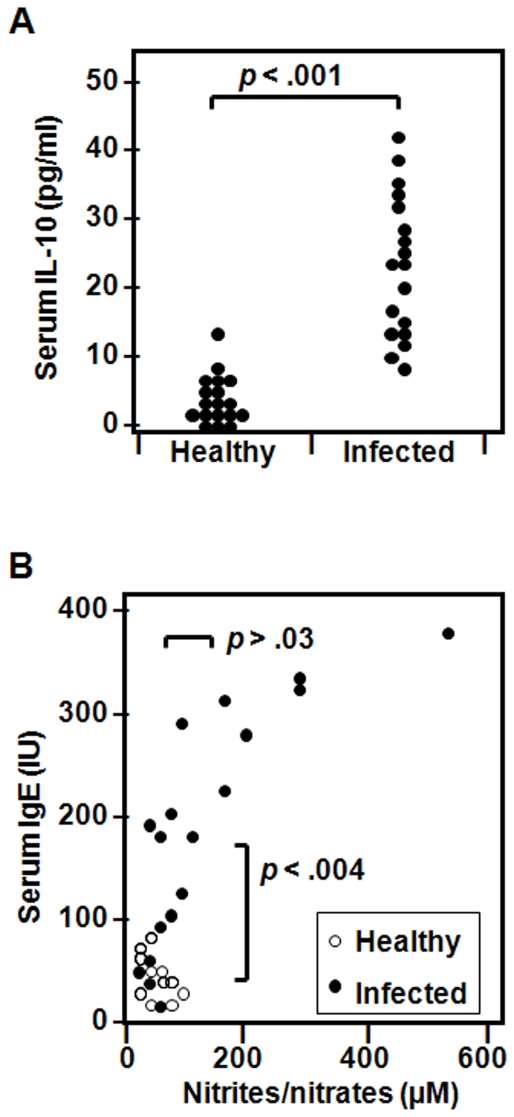
The presence of IL-10, IgE and nitrites in sera from patients infected with T. gondii.Freshly isolated sera from 18 T. gondii infected patients or 11–18 uninfected controls were tested for the levels of IL-10, IgE and nitrites. (A) Infected patients have significantly high serum levels of IL-10 compared to controls. (B) Elevated IgE levels were detected in infected patients compared to controls, while concentrations of serum nitrites were close to normal values except to 6/8 patients with high IgE (>200 IU) levels (p<0.018).